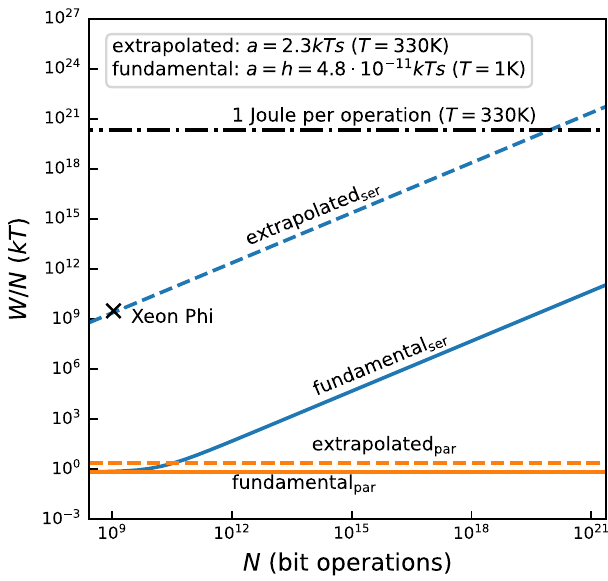
Fig.3|Fundamentallimitandextrapolatedenergycostperoperationforideal serial and parallel computers. Fundamental limits obtained for a = h (Planck constant; T =1 K ) (solid lines) and extrapolated energy cost corresponding to a =2.3 kT s (Xeon Phi; T =330 K ) (dashed lines) for ideal serial, Eq. (3) (blue), and parallel, Eq. (4) (orange), computers. The measured valueforaXeon Phiprocessor is represented by a black X. For reference, anenergy cost of 1 J/operation isshown as a dash-dotted line. Parameters are T =1 s and b